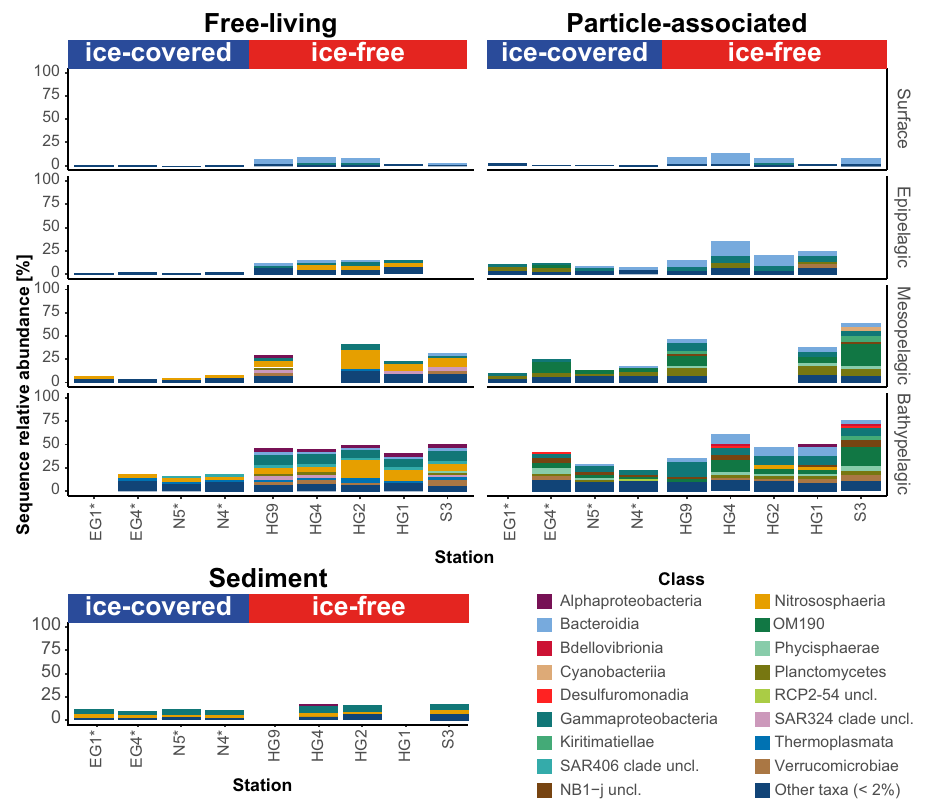
Fig. 6 Relative sequence abundance of PA-enriched ASVs in water column and sediment microbial communities. Only the sequence proportion of ASVs that were found enriched along the water column in PA communities were included in the fi gure. The classes represented by colors according to the legend, all classes with sequence proportion below 2% were classi fi ed as “ Other taxa ” . The ice-covered stations are marked with an